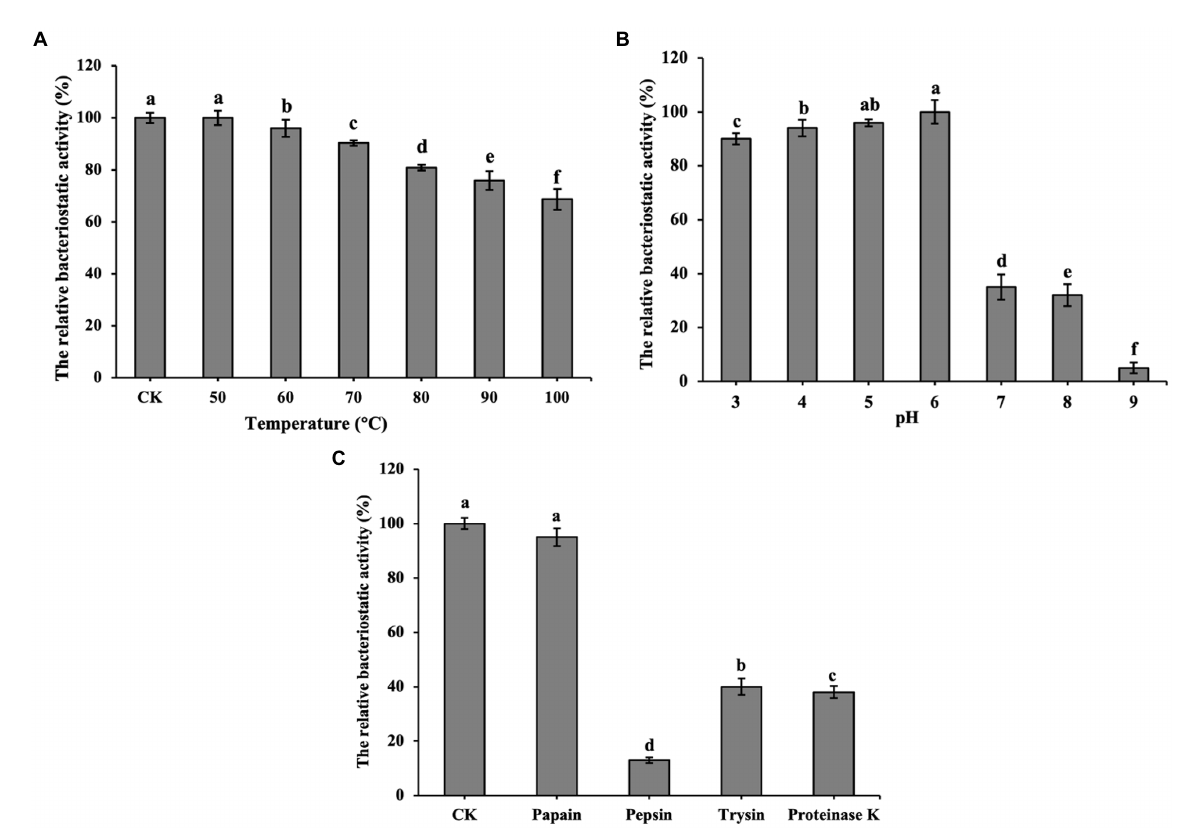
FIGURE 3 (A) Influence of temperatures on the antibacterial activity of bacteriocin ZFM216; (B) Influence of different pH on the antibacterial activity of bacteriocin ZFM216; (C) influence of different protease on the antibacterial activity of bacteriocin ZFM216 (different letters indicate significant differences in